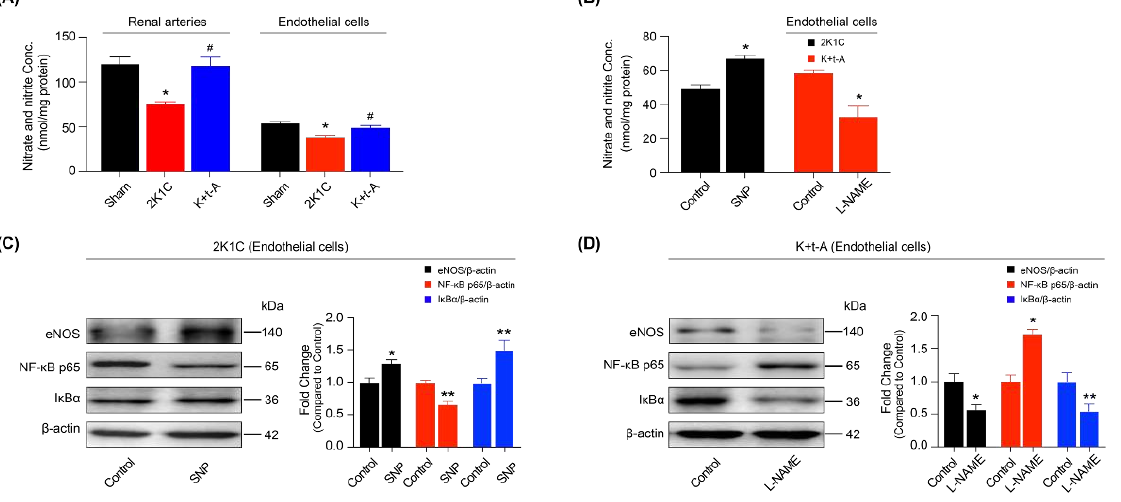
Figure 7. Modulation of nitric oxide (NO) on I κ B α , NF- κ B p65, and eNOS expression. The concentration of nitrate and nitrite in the renal arteries and endothelial cells ( A ). The effects of SNP or L-NAME on nitrate and nitrite concentrations in the endothelial cells, from 2K1C or 2K1C + t-AUCB (K + t-A) renal arteries ( B ). Expressions of I κ B α , NF- κ B p65, and eNOS in the 2K1C rat endothelial cells cultured with 20 μmol/L SNP for 24 h ( C ) and those in the 2K1C + t-AUCB rat endothelial cells treated with 100 μmol/L L -NAME for 30 min ( D ). n = 4 – 9 per group. Data are presented as mean ± SEM. * p < 0.05, ** p < 0.01 vs. Sham or respective control; # p < 0.05 vs. 2K1C.